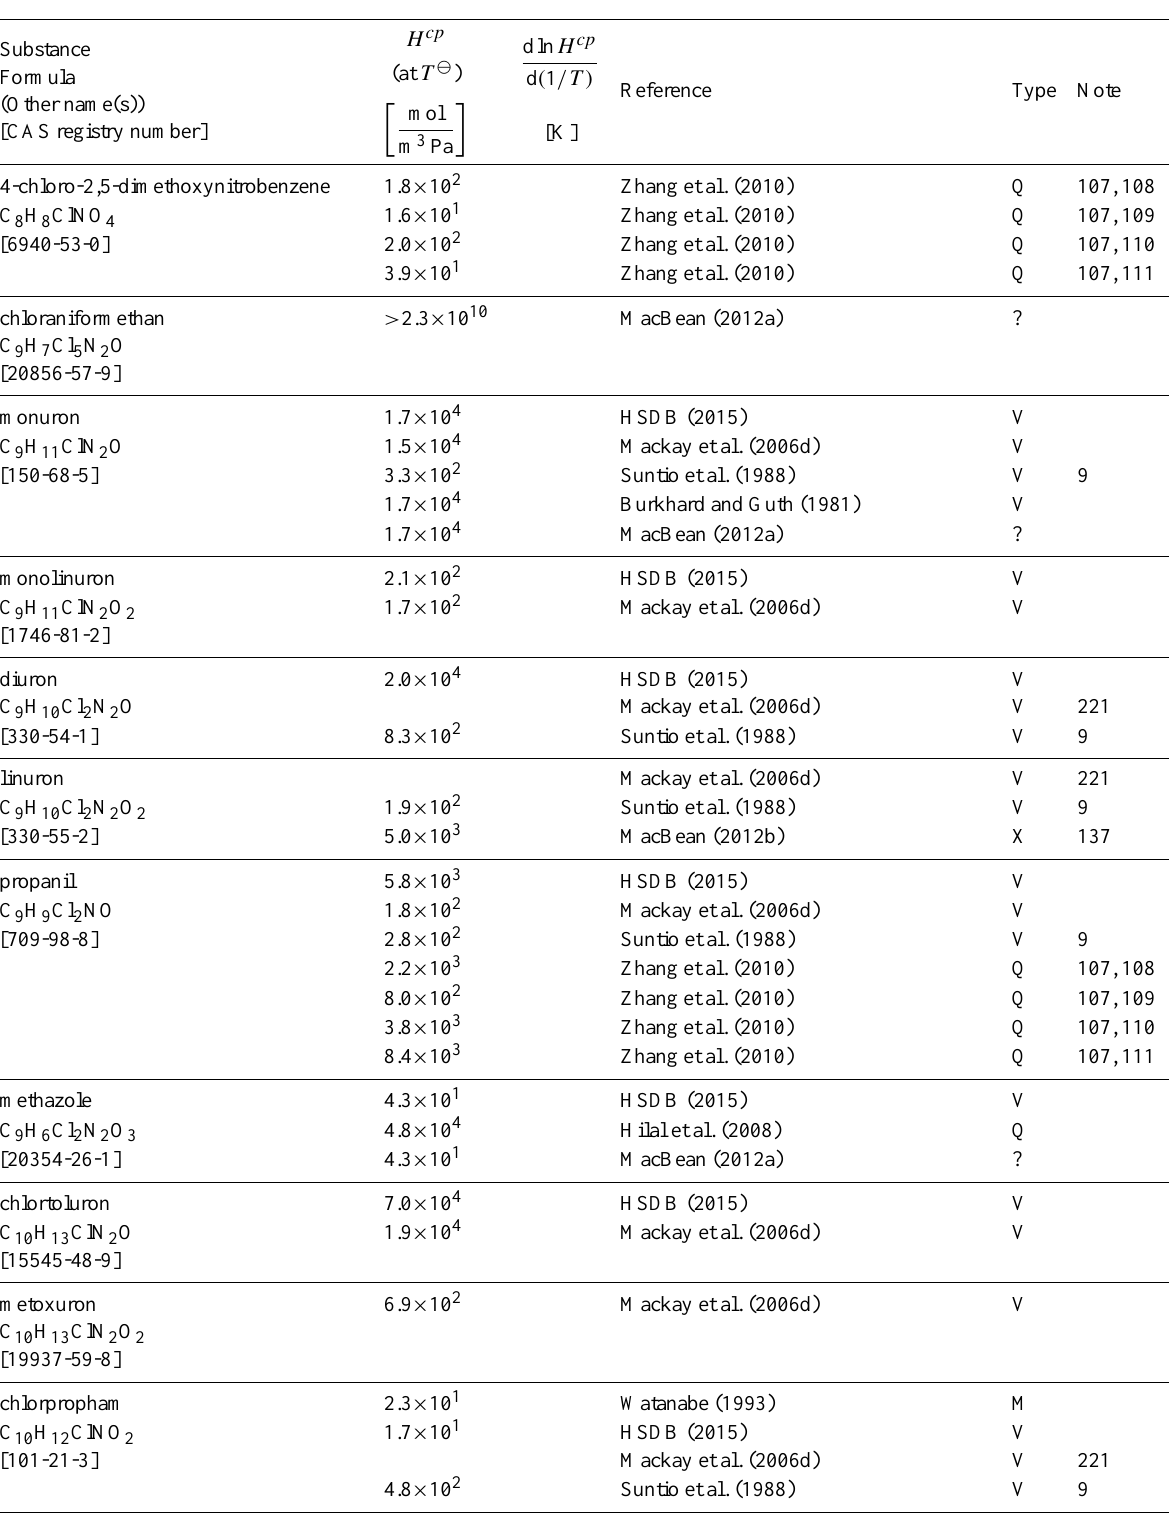
Table 6: Henry’s law constants for water as solvent